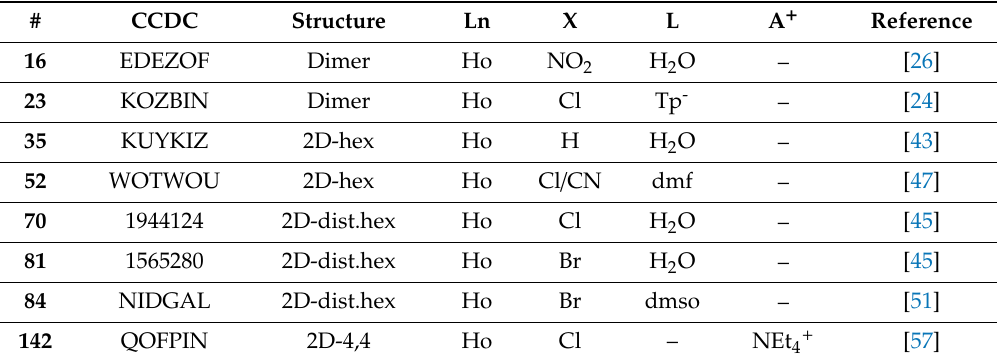
Table 23. Structurally characterized Ho(III) compounds with anilato ligands.